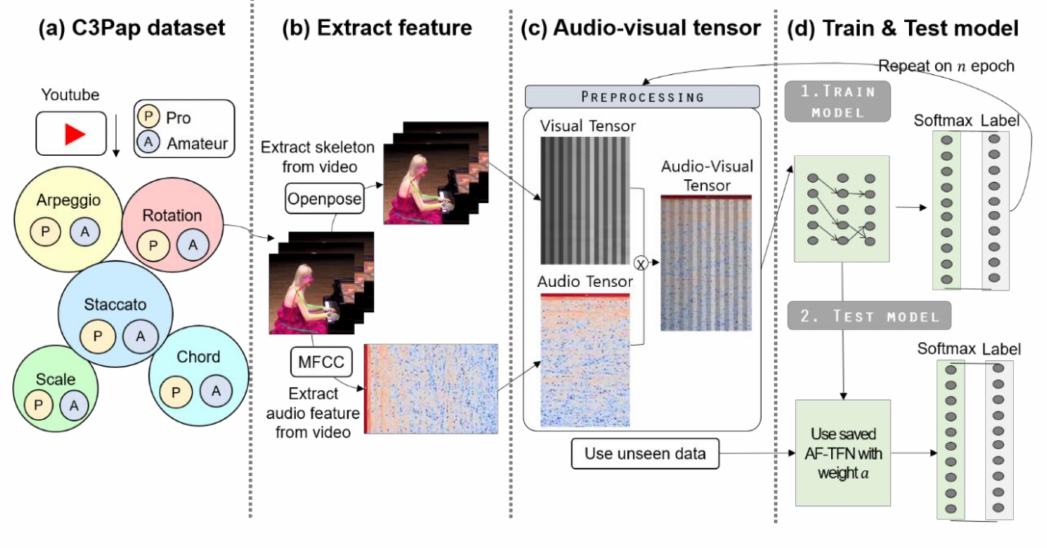
Figure 3. Overall process of AV-TFN.